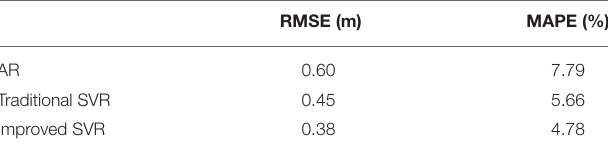
TABLE 7 | Analysis of overall